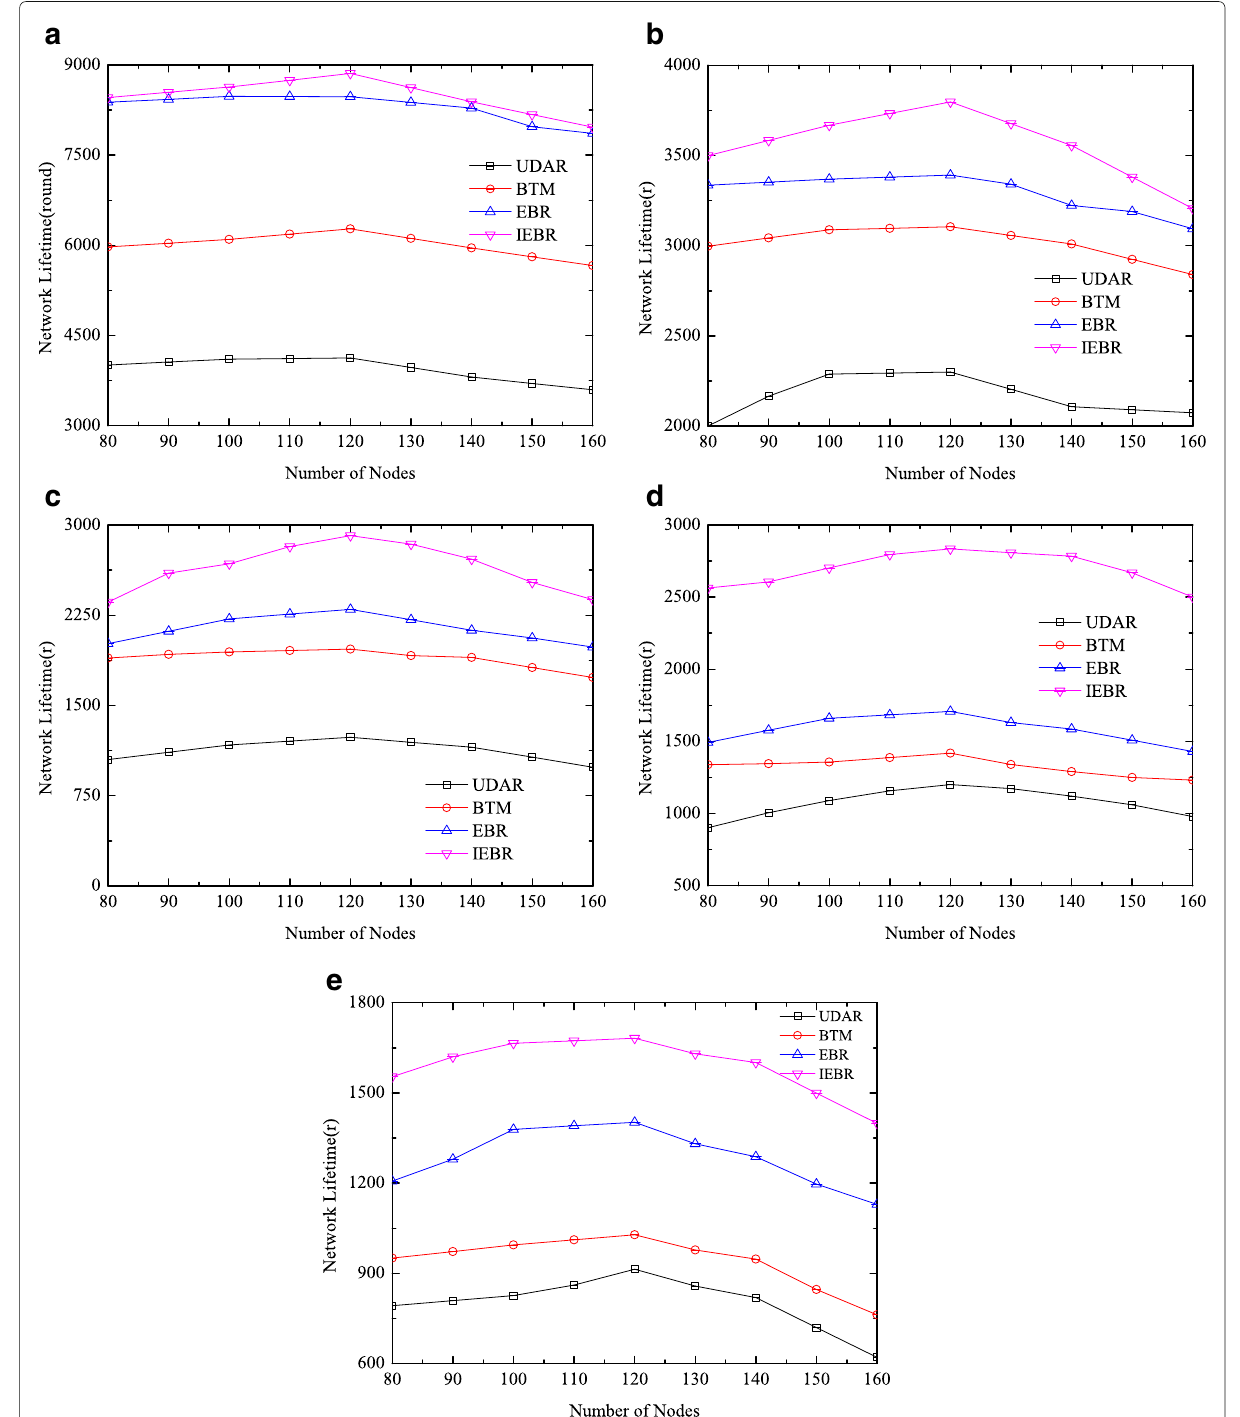
Fig. 11 The network lifetimes with different network radiuses and numbers of nodes. a Network radius = 1km. b Network radius = 2km. c Network radius = 3km. d Network radius = 4km. e Network radius = 5km network lifetime by about 25%. The comparisons show that IEBR has an advantage in network lifetime over other algorithms with different network radiuses and numbers of nodes.